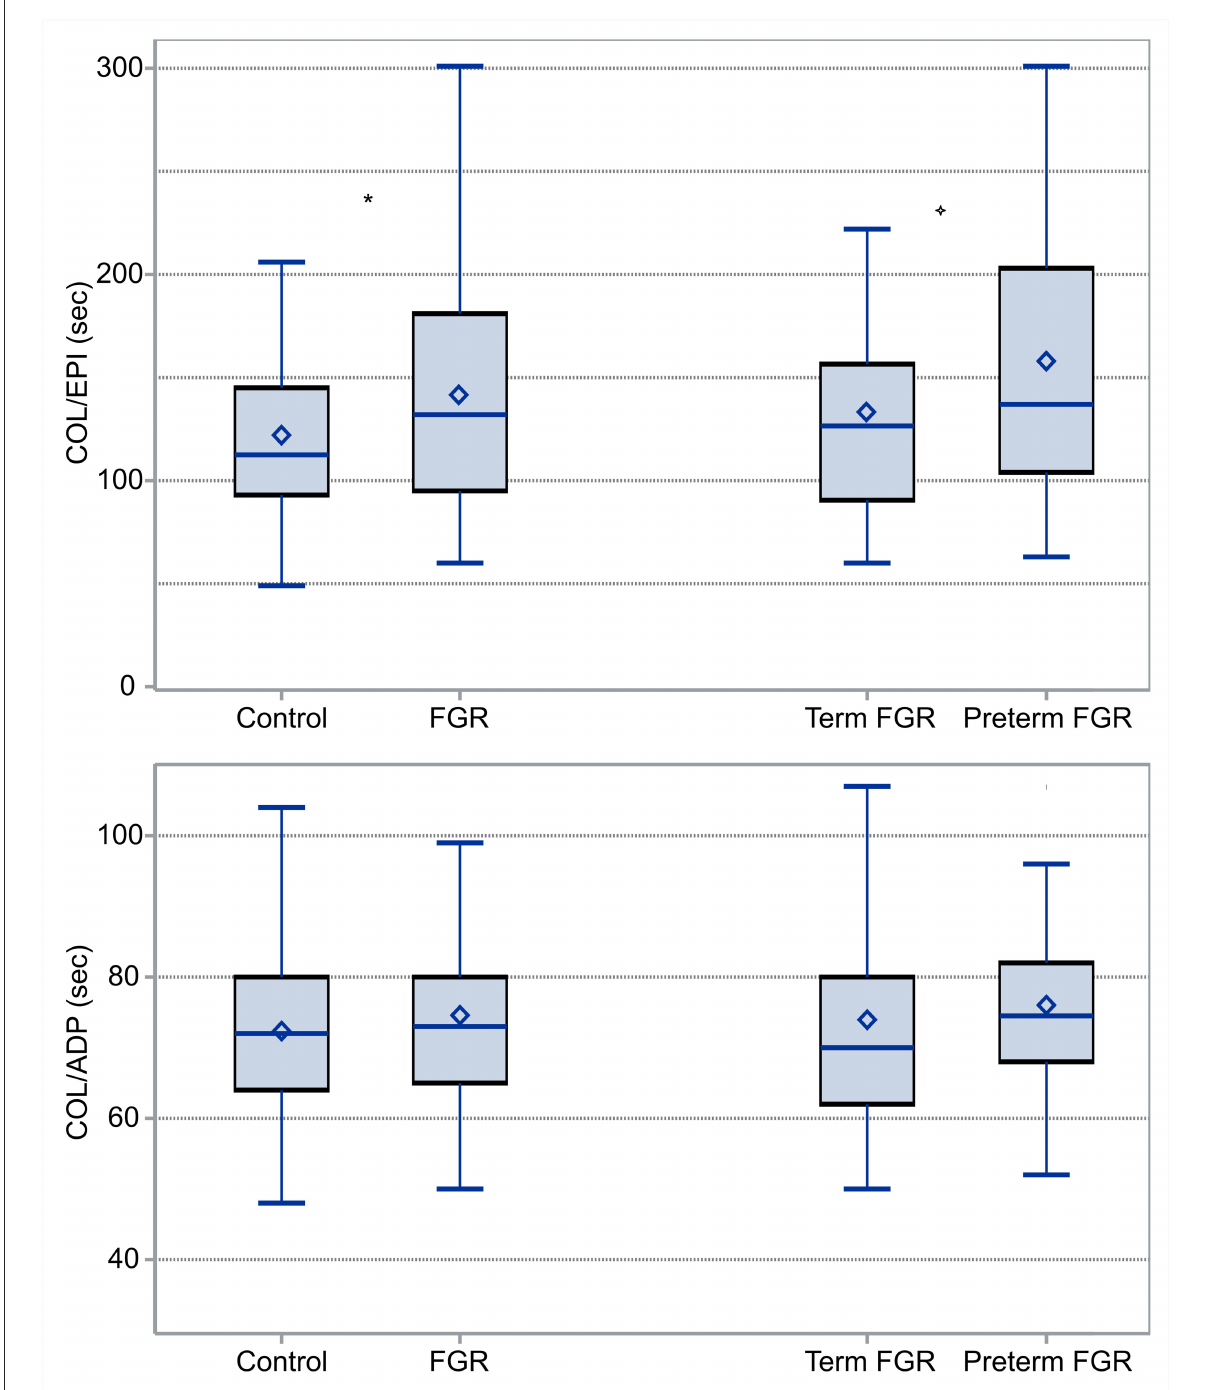
FIGURE2 Box and Whisker plots comparing COL/EPI (top) and COL/ADP (bottom) CTs between FGR and control neonates and term and preterm FGR neonates: COL/EPI and COL/ADP are expressed in seconds. *indicates statistically significant